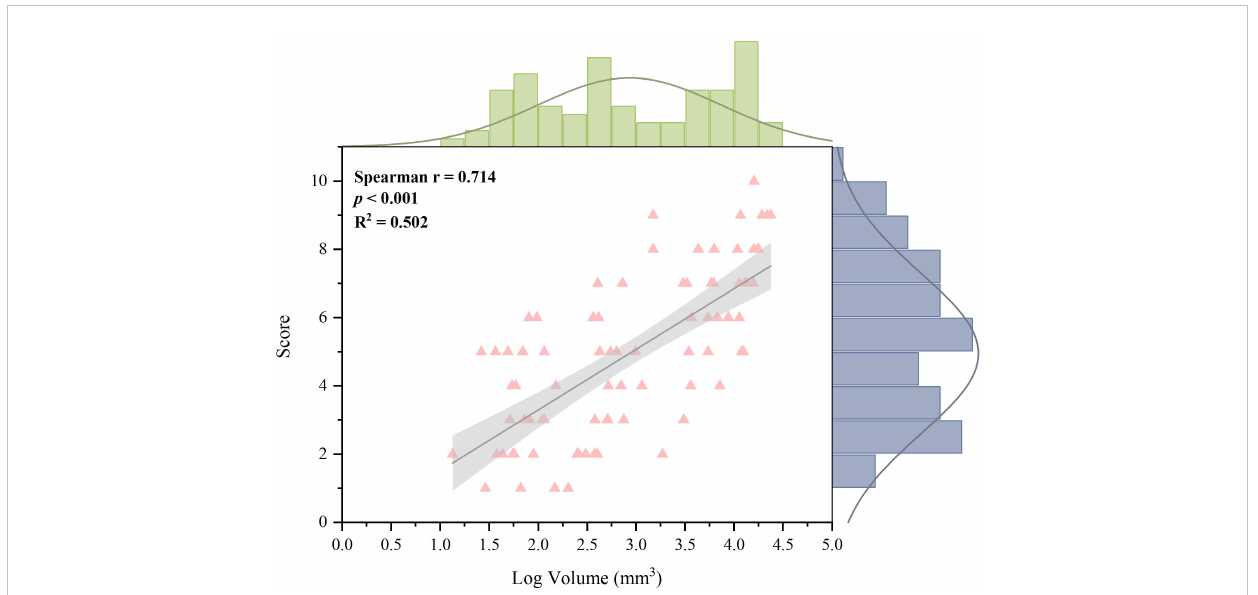
FIGURE 6 Correlation between erosion score and logged volume of MSU deposition for 80 joints with both tophus burden and bone erosion. A strong and positive relationship was found (Spearman correction coef fi cient, 0.714; p < 0.001). MSU, monosodium